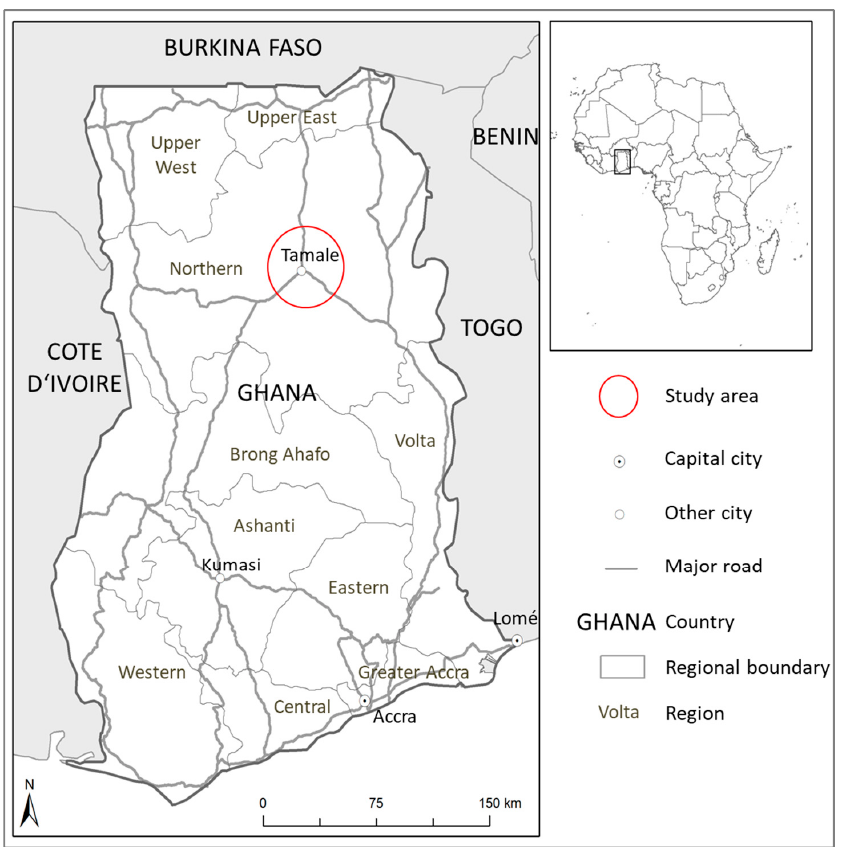
Figure 1. Location map of Tamale in the Northern Region of Ghana.